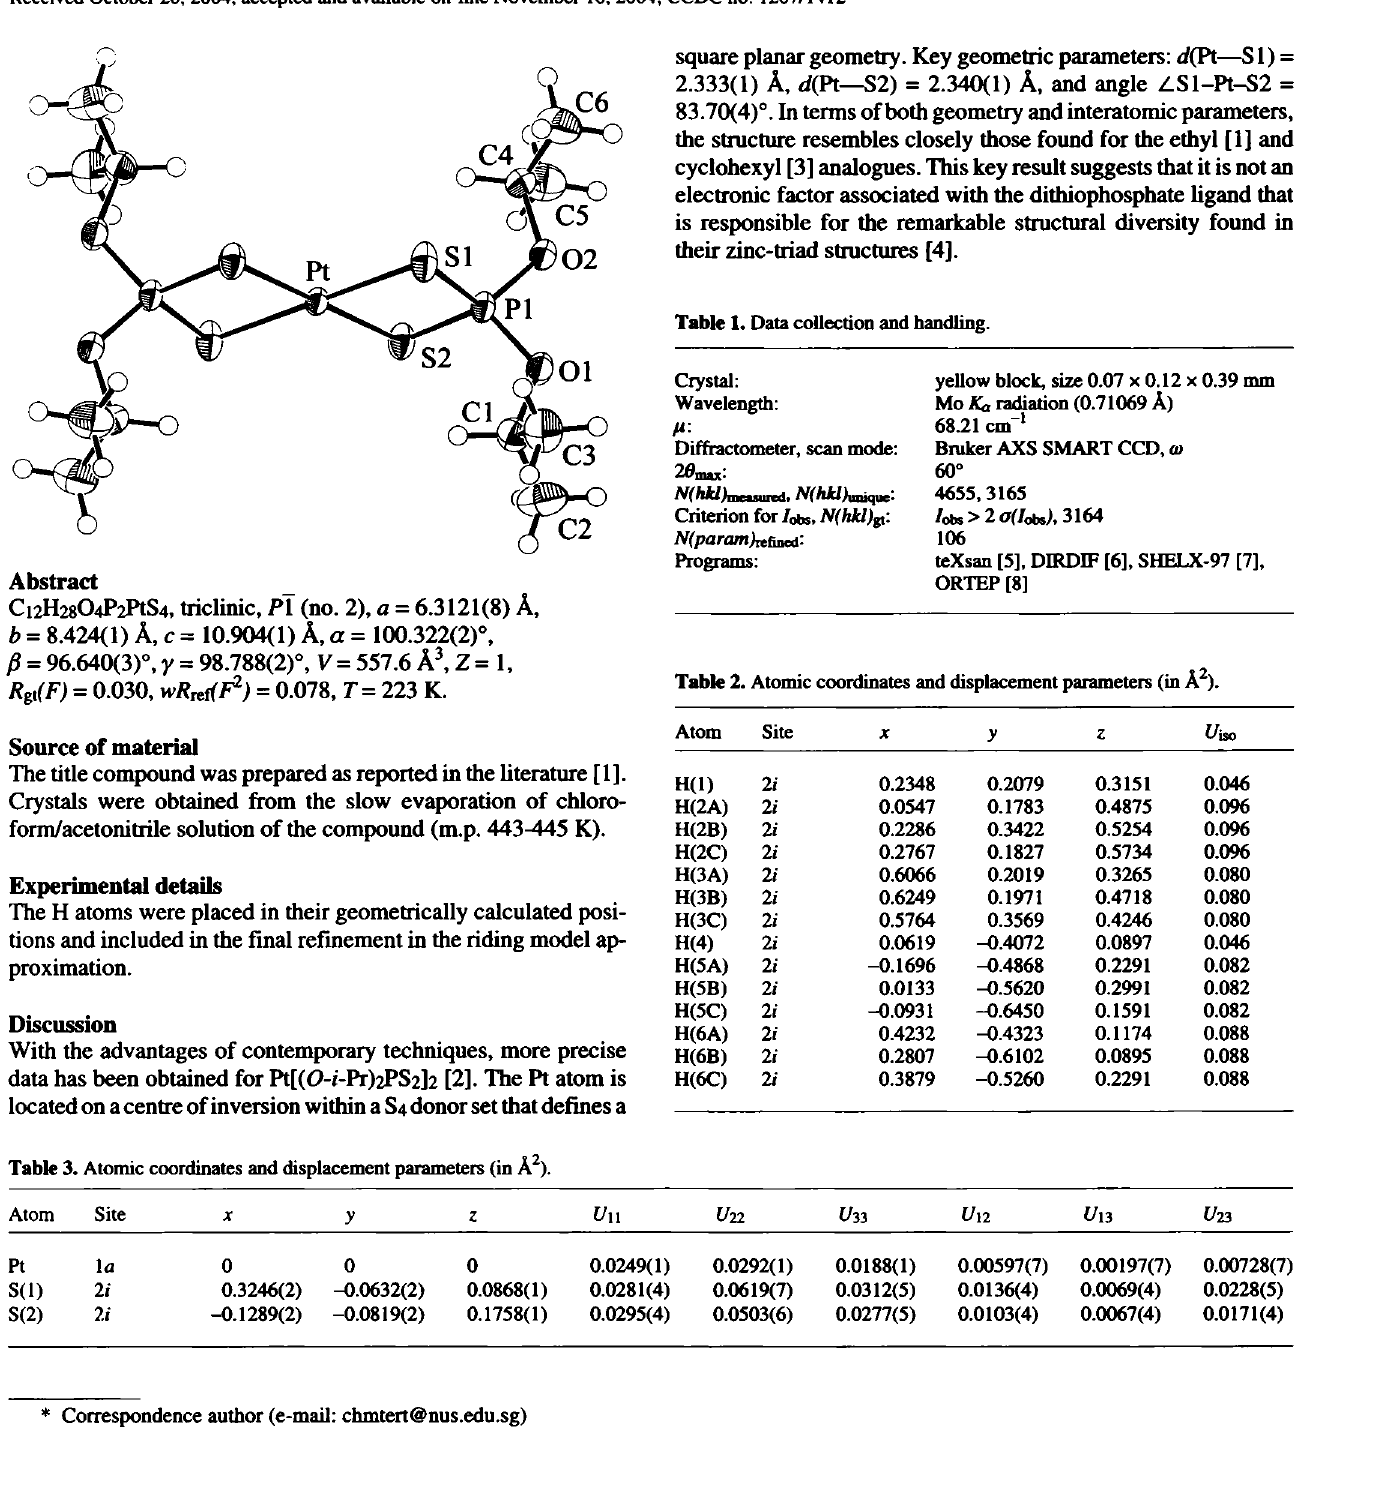
Table 3. Atomic coordinates and displacement parameters (in À 2 ). Atom